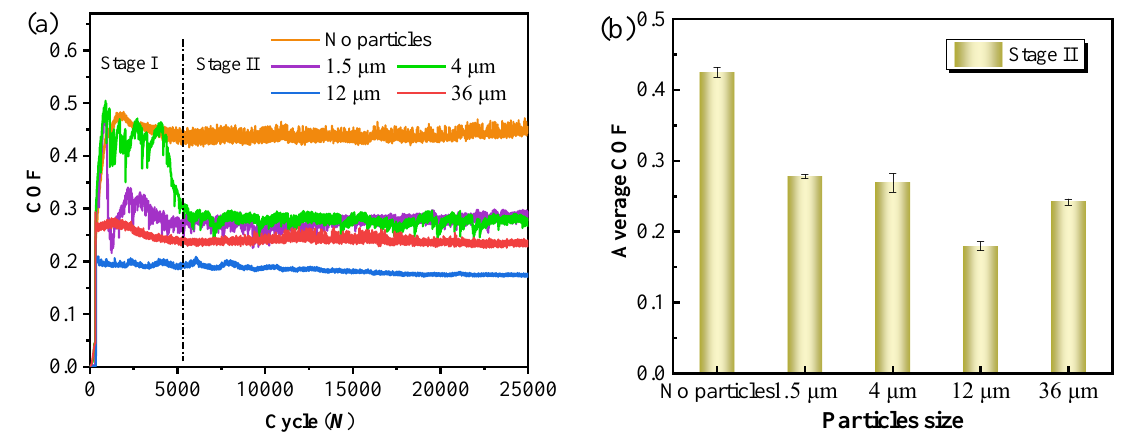
Figure 4. COF under different particle size conditions: ( a ) time-varying curve of COF; ( b ) the average COF of stage II.